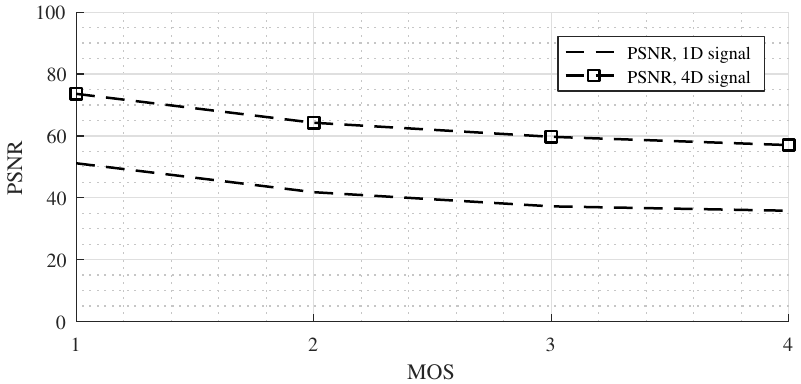
Figure 7. Peak signal-to-noise ratios (PSNRs) for different multiples of overlap size (MOSs) with Non-linear 2 1D and 4D signals.